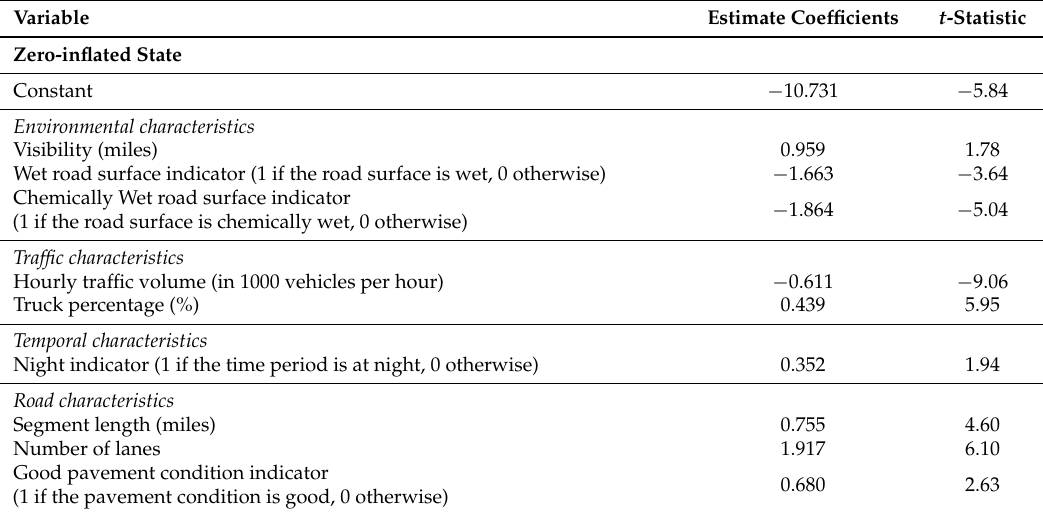
Table 2. Random effect zero inflated negative binomial estimation